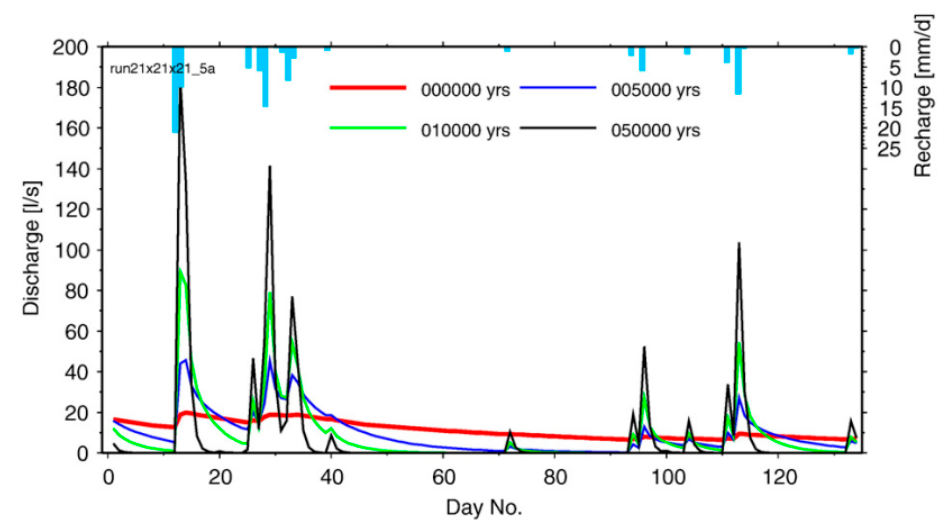
Figure 18. Short-term spring response in the stationary model: recharge and discharge time series for different evolution times. Yrs is the abbreviation of years. For example, 005000 yrs shows the evolution of channels after this time. Run21 × 21 × 21_5a shows the model domain that is discretized into 21 × 21 × 21 nodal points. 5a indicates the fifth uplift of the basin [58].